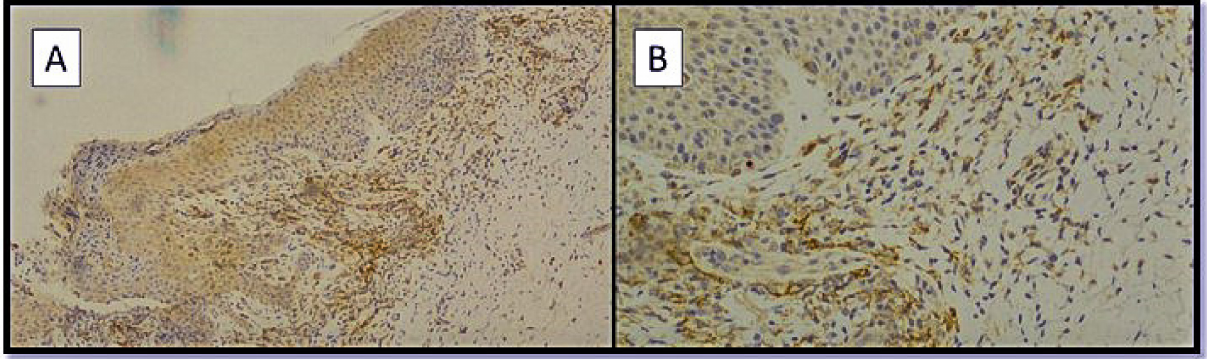
Figure 4. ( A ) Preparation for immunostaining with anti-ACE2 antibody from skin samples of SARS- CoV-2-positive patients. Note the focal positivity of the immunolabeling of the basal keratinocytes and of some keratinocytes of the Malpighian (spinose) and granular layer (Immunohistochemistry anti-ACE2, original magnification: 4 × ). ( B ) Detail of image A showing mild positivity of the ACE2 immunolabeling of some adenomeres of eccrine sweat glands and fibroblasts (Immunohistochemistry anti-ACE2, original magnification: 20 ×